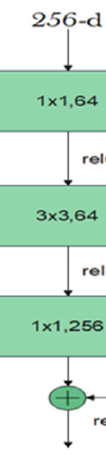
Figure 3. Bottleneck design of the residual block.